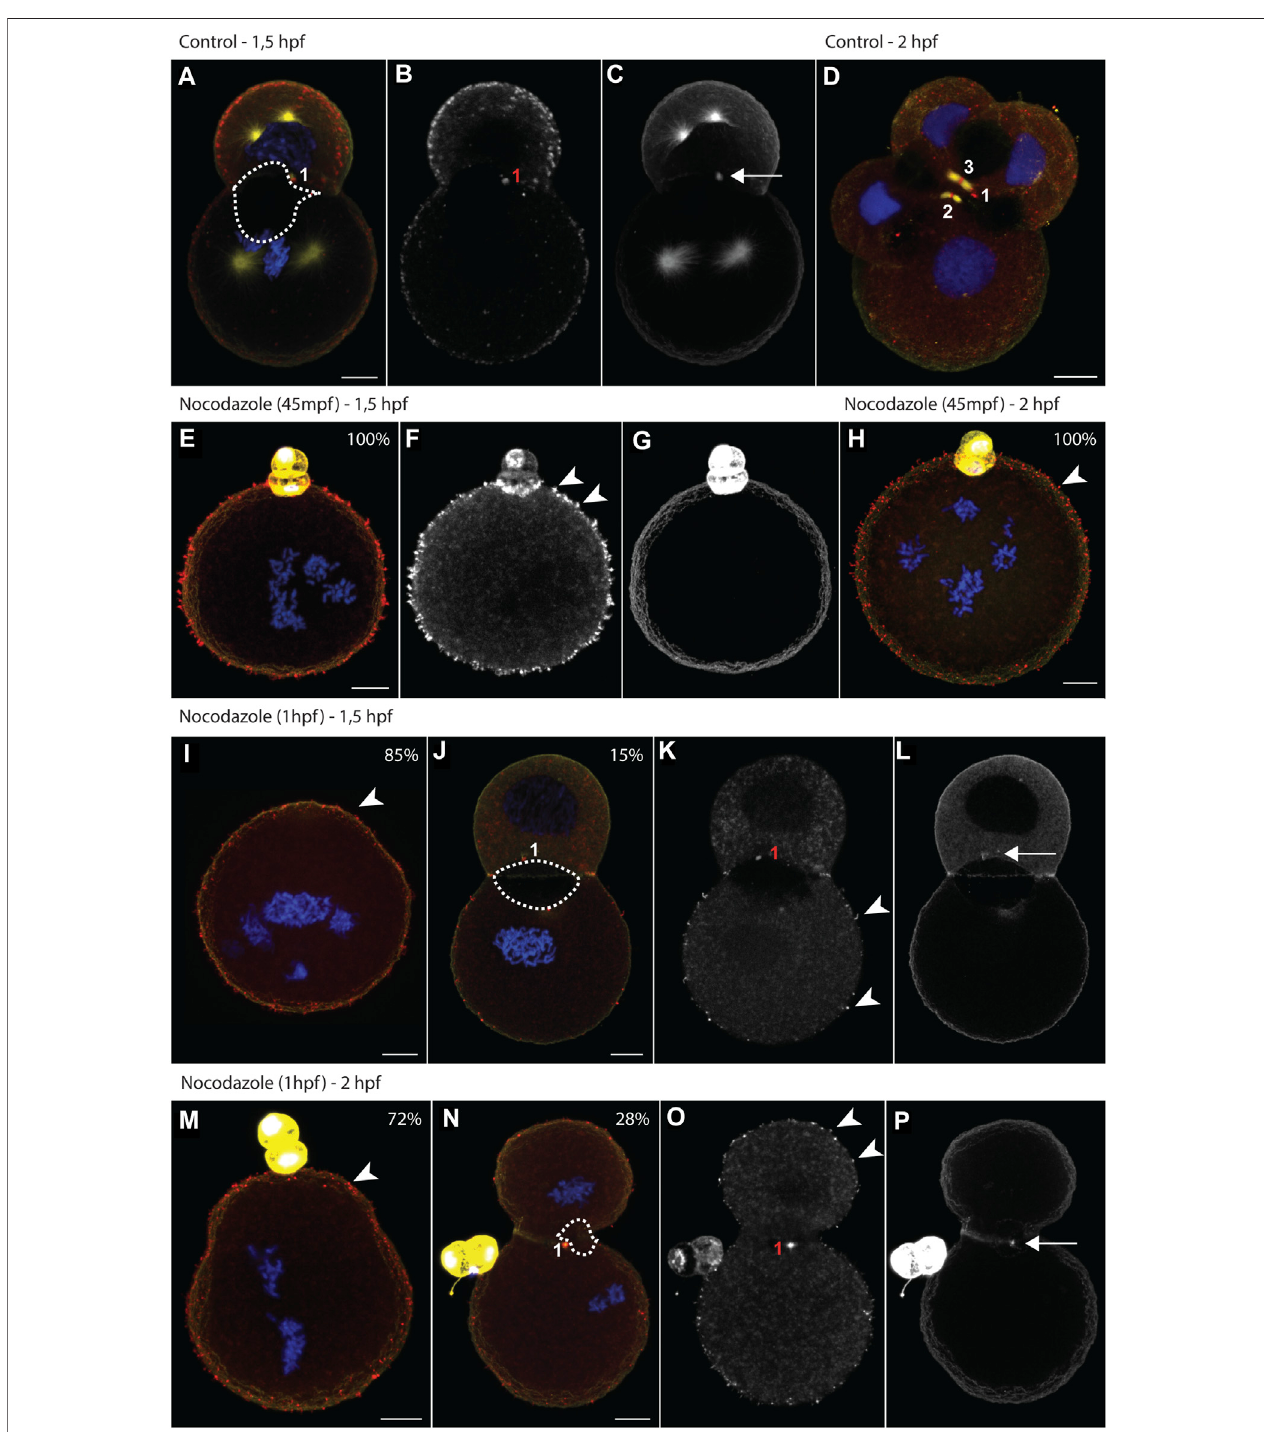
FIGURE 3 | Nocodazole treatments trigger aquaporin translocation and impair lumenogenesis. (A – P) Maximum intensity projections of Dreissena rostriformis embryosat1.5hpf (A – C,E – G,I – L) and2hpf (D,H,M – P) .Embryosweretreatedwith10 μMnocodazoleeitherfrom45mpf (E – H) orfrom1hpfonwards (I – P) .Valuesin the upper right corner of an image indicate the percentage of embryos with the depicted phenotype for the respective treatment condition. Hoechst labeling of nuclei is shown in blue, Dro-lt-AQP1 immuno fl uorescence is shown in red (A,D,E,H,I,J,M,N) or grey-scale (B,F,K,O) and acetylated/tyrosinated alpha-tubulin immuno fl uorescence is shown in yellow (A,D,E,H,I,J,M,N) or grey-scale (C,G,L,P) . Midbodies are numbered in the order of their formation during the fi rst (1) and second cleavages (2 and 3). The dotted outline in (A,J,N) indicates the maximal expansion of the cleavage cavity. Arrows indicate remnants of the cytokinetic bridge (C,L,P) and arrowheads point to Dro-lt-AQP1-immunoreactive membrane protrusions (F,H,I,K,M,O) . Scale bars, 10 μm.